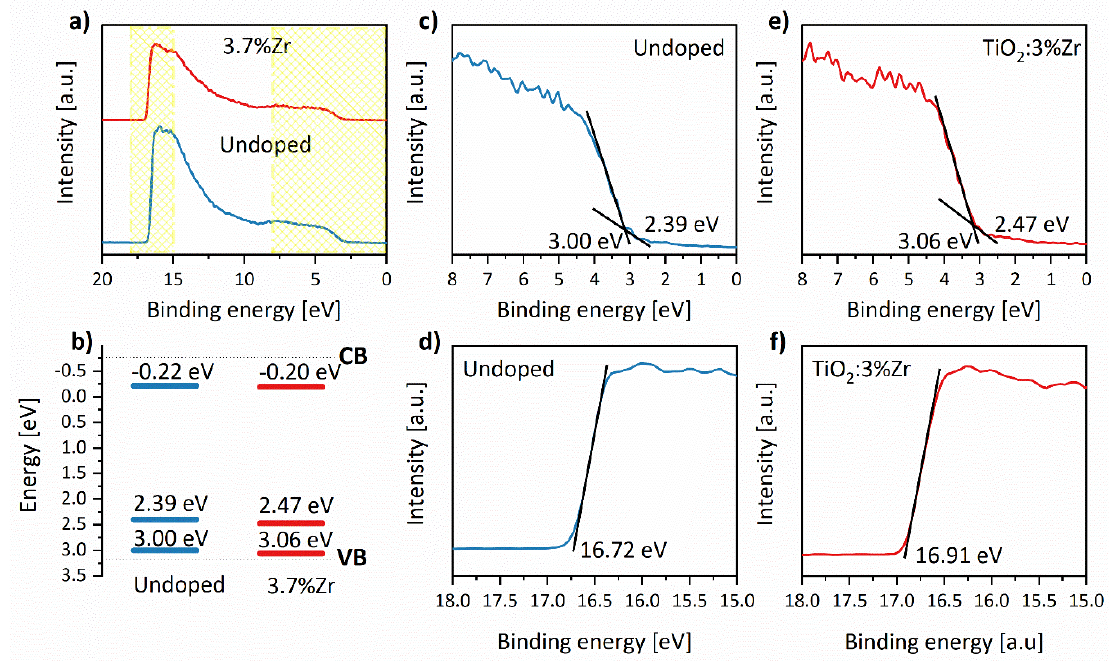
Figure 11. UPS spectra of undoped TiO 2 ( a , c , d ) and nanomaterial with 3.7% content of Zr 4+ ions ( a , e , f ) with a scheme of the energy structure band ( b ). The enlargements of valence bands ( c , e ) and secondary electron cut-offs ( d , f ) are shown.